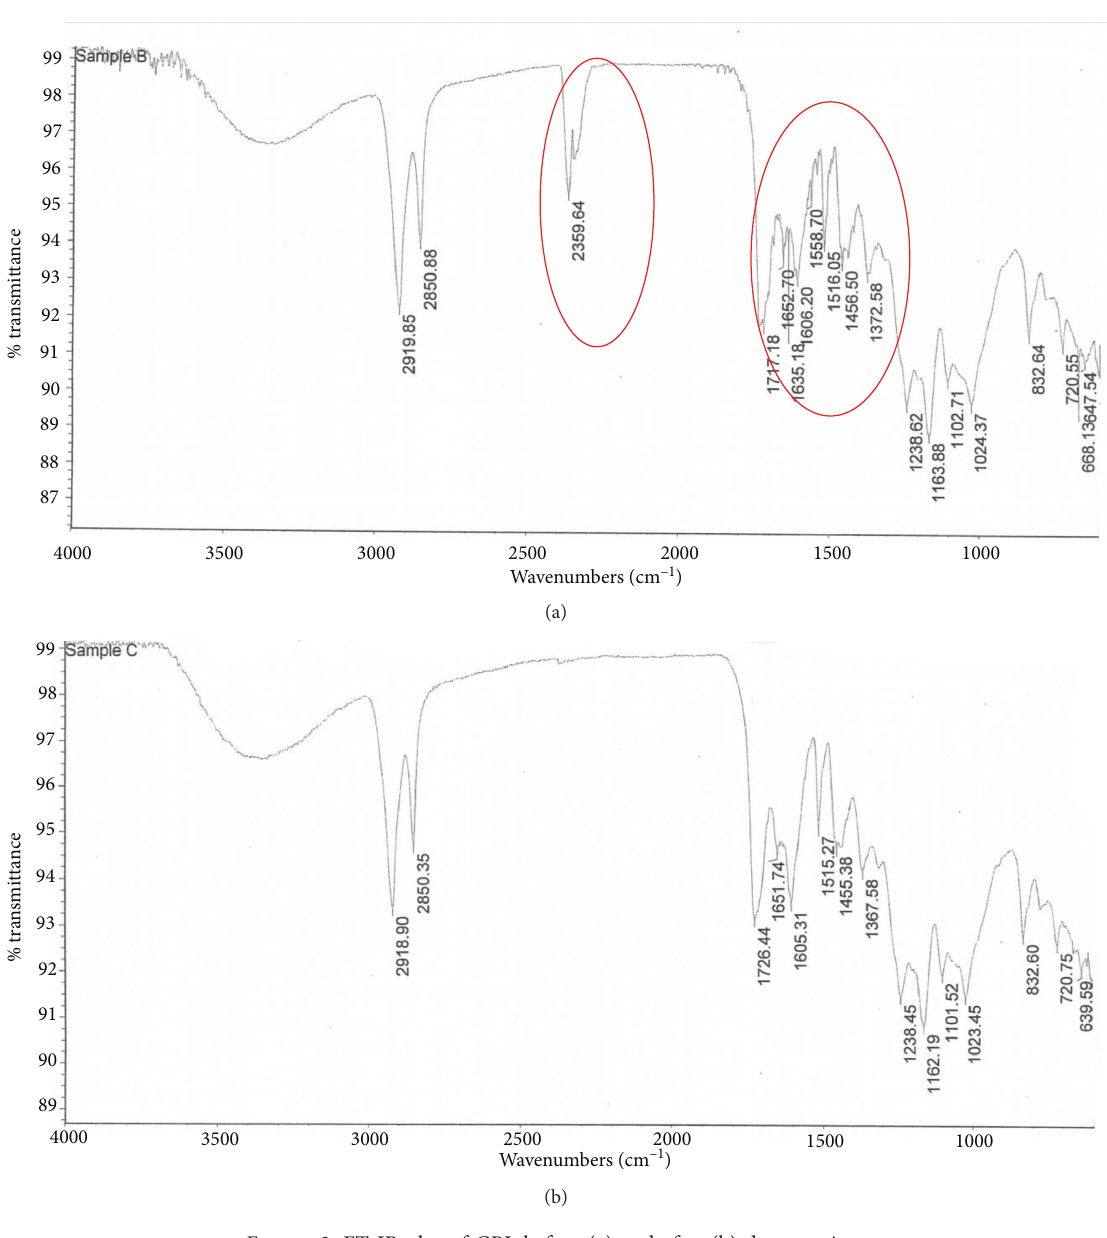
Figure 2: FT-IR plot of GBL before (a) and after (b) dye